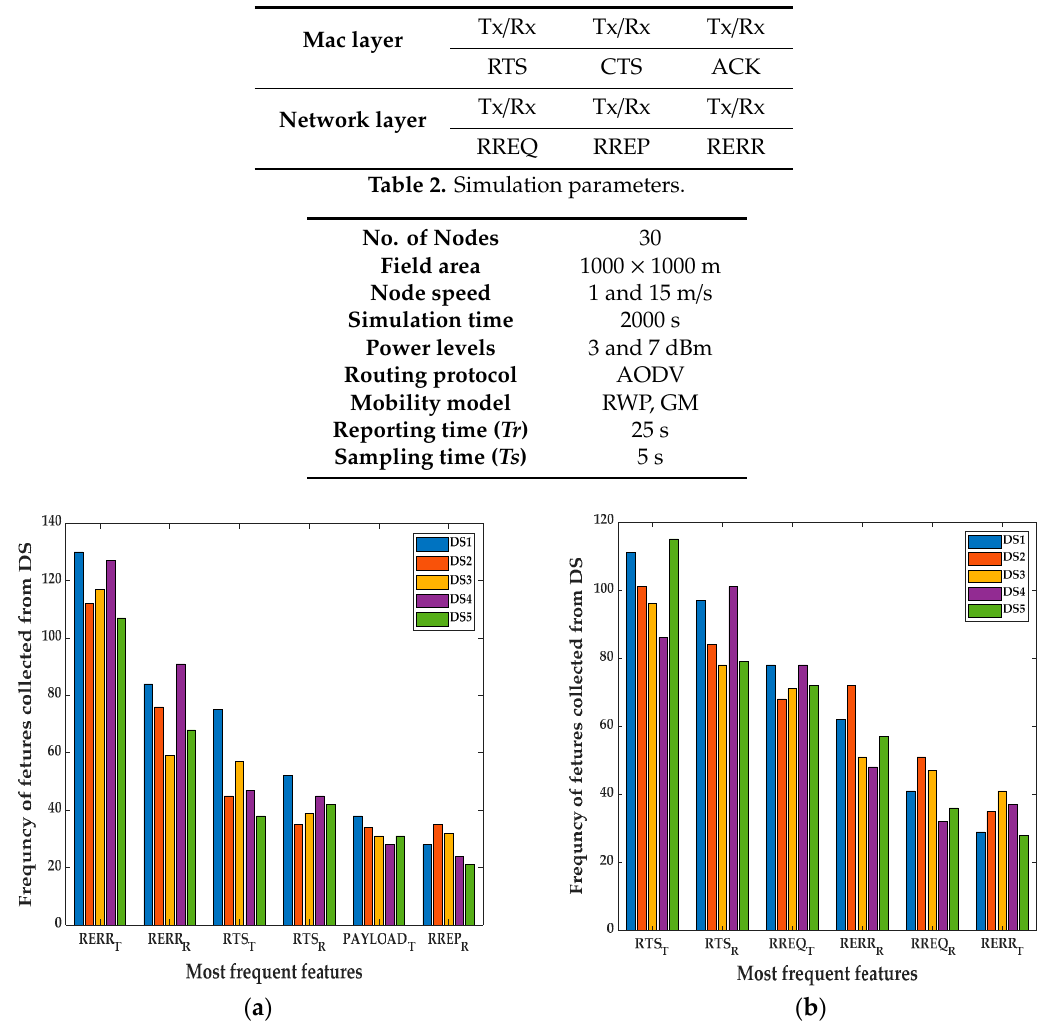
Table 1. Cross layer features.